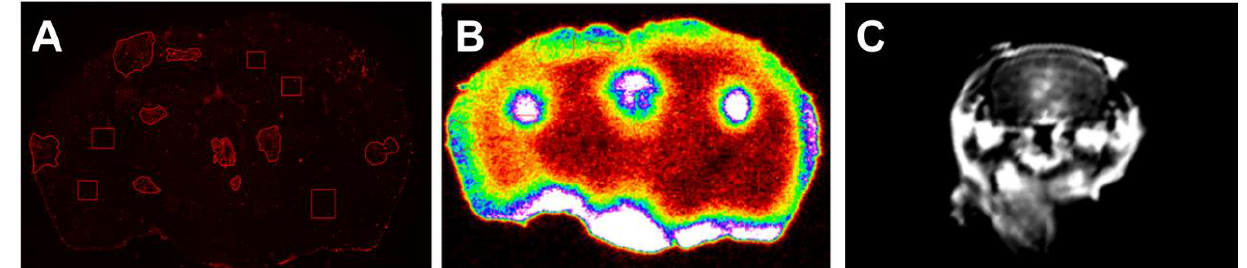
Figure 4. Differential tracer uptake in various imaging modalities. Accumulation of Texas Red 3K ( A ) and 14C-aminoisobutyric acid ( B ) in brain metastases of breast cancer using fluorescent and phosphorescent quantitative imaging. ( C )T1 cortical Turbo Spin Echo MRI indicating gadavist enhancement in lesions within the brain.